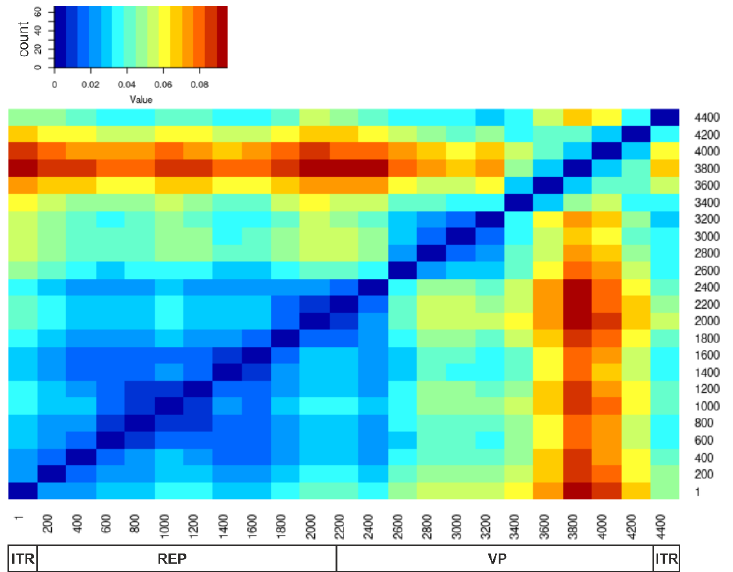
Figure 1. Pairwise distance deviation matrix (PDDM) for AAV A alignment. PDDM summarizes the multitude of pairwise nucleotide distance comparison plots (PDCP) for all possible genome region pairs, visualized as a heatmap. A higher (“red”) value of the color key indicates lower overall sequence distance congruence between two genome regions, which is likely caused by recombination.